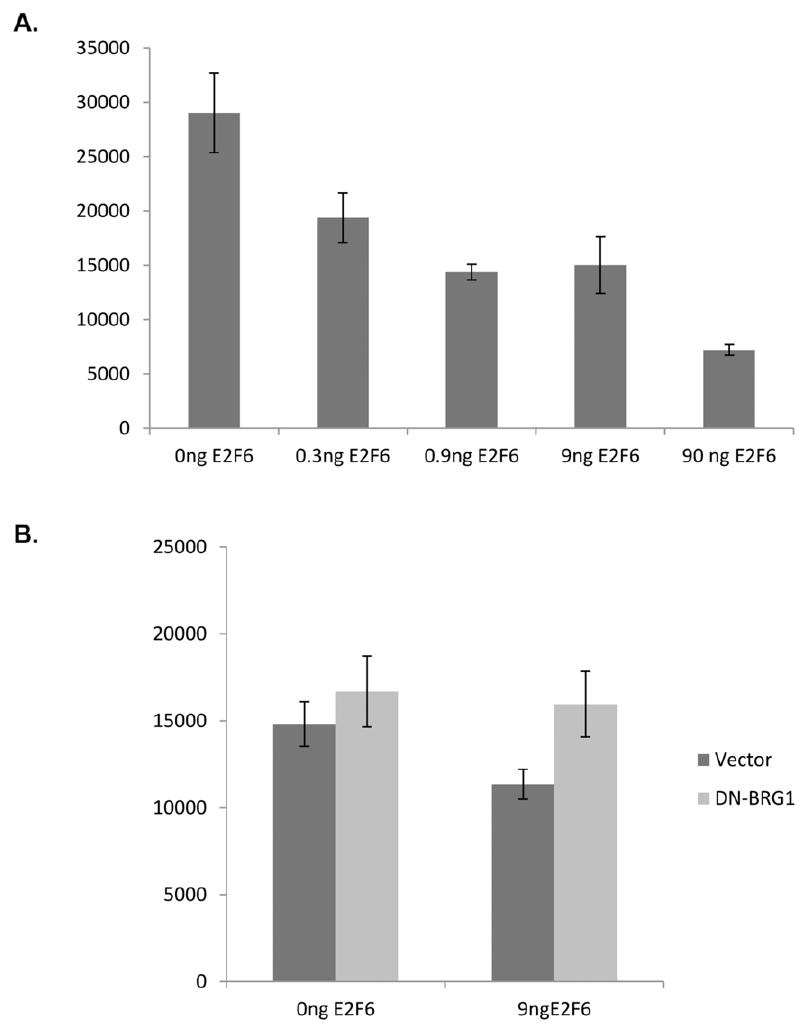
Figure 5. E2F6 repression of the E2F1 promoter is hindered by a dominant negative BRG1. Transfections were performed using T98G cells plated onto 6-well dishes. All wells were co-transfected with a construct expressing Lac Z and a E2F1 reporter plasmid in addition to the indicated plasmids. Luciferase activity was determined from triplicate samples and expressed as the average relative luciferase units after normalization to b -galactosidase activity. A) Increasing concentrations of E2F6 is correlated with a decrease in E2F1 reporter activity. A plasmid construct expressing E2F6 was transfected into T98G cells in 6 well dishes at the indicated amounts. The total mass of transfected DNA in each well was kept constant by adding empty vector plasmid DNA, when necessary. B) The ability of E2F6 to downregulate E2F1 promoter activity is inhibited by the presence of a dominant negative BRG1. A plasmid expressing a dominant negative BRG1 or an empty vector control was co-transfected with a plasmid construct expressing E2F6 into T98G cells. Luciferase activity was determined as described